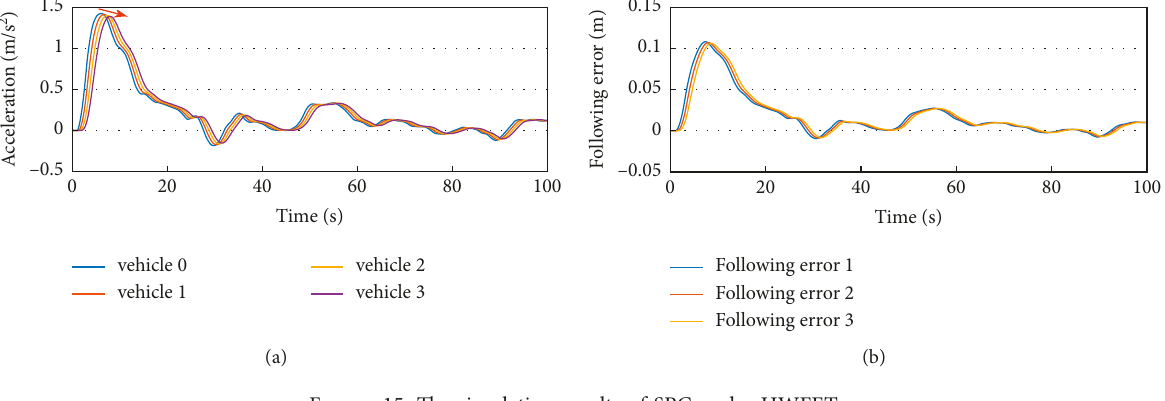
Figure 15: The simulation results of SPC under HWFET.